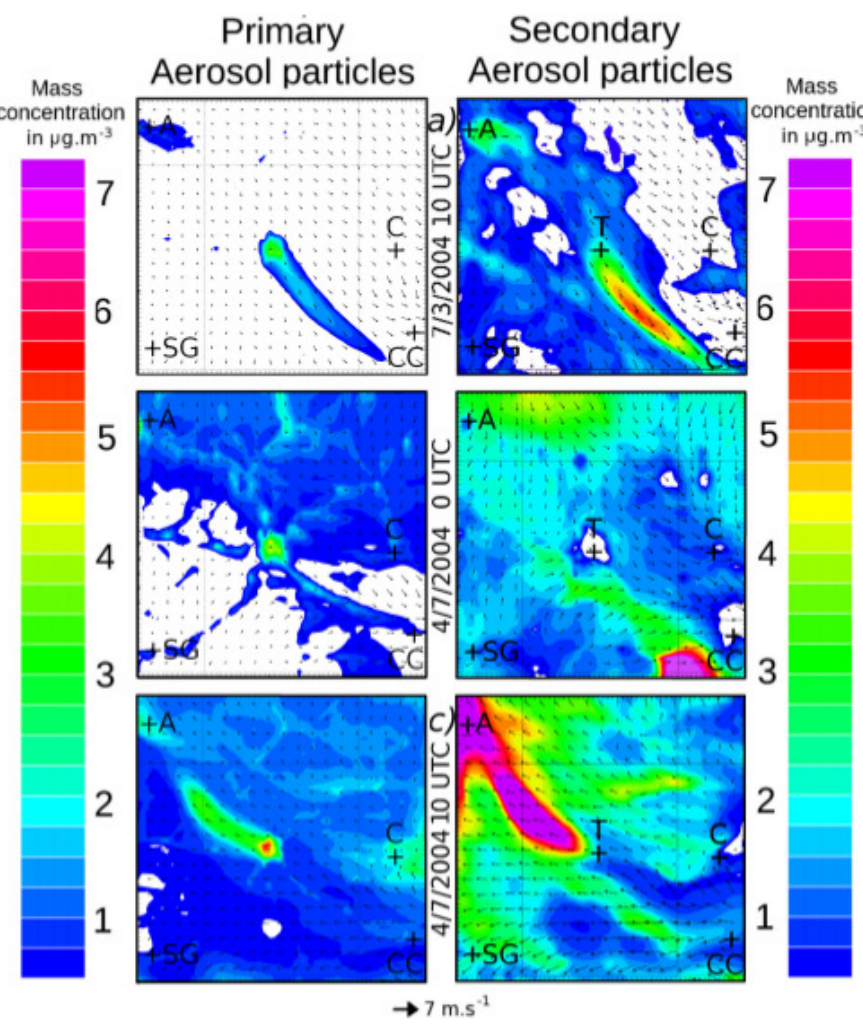
Fig. 3. Primary (left) and secondary (right) aerosol mass concentrations in µgm − 3 over the second domain (a) on 3 July 10:00UTC, (b) on 4 July 00:00UTC and (c) on 4 July 10:00UTC with the wind vectors at the ground level (black arrows).Black crosses mark the location of regional cities: T for Toulouse, A for Agen, C for Castres, SG for Saint-Gaudens, and CC for